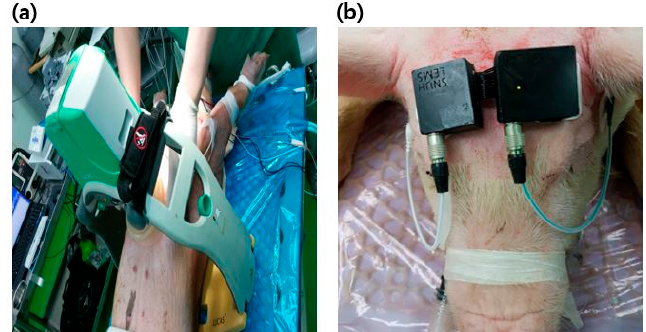
Figure 1. Experimental setup: ( a) LUCAS2 chest compression system installed on the chest of animals; ( b ) A single-channel electroencephalography (EEG) device mounted on the forehead.